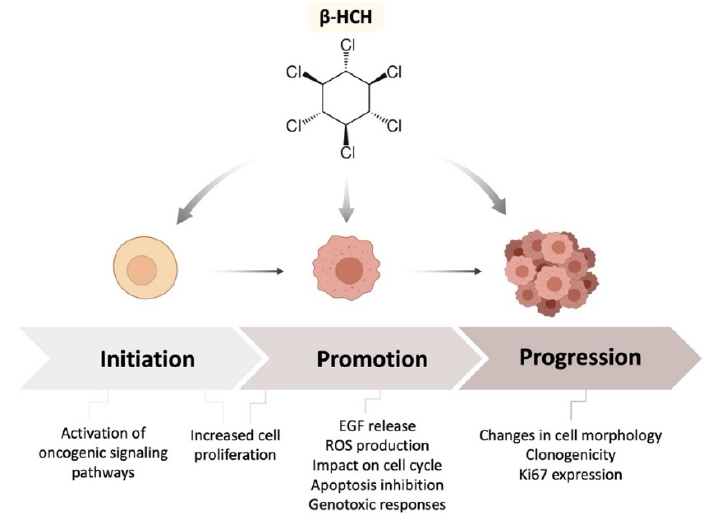
Figure 13. Schematic summary of β -HCH’s impact on all three stages of carcinogenesis.